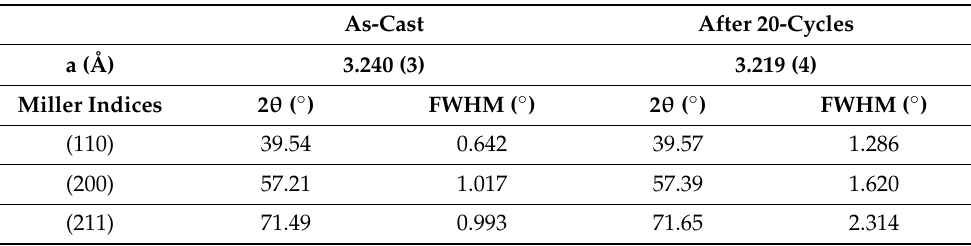
Table 4. Lattice parameter, FWHM of (110), (200) and (211) diffraction peaks for the as-cast sample and the desorbed sample after 20